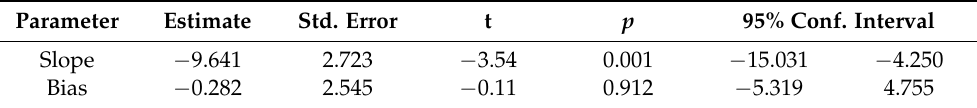
Table 6. Egger’s test for examining publication